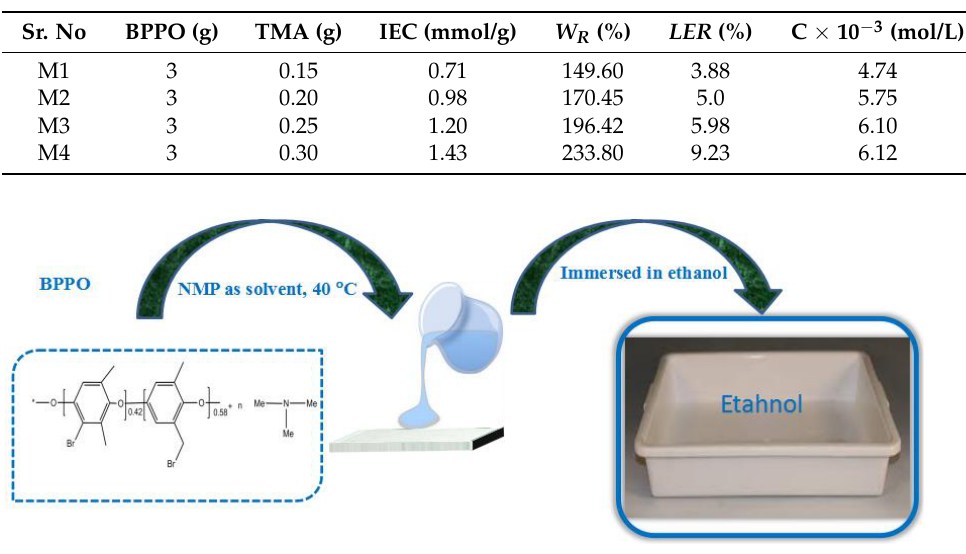
Table 1. Composition, ion exchange capacity, fixed group concentration, water uptake, and mem- branes swelling of membranes M1 to M4.